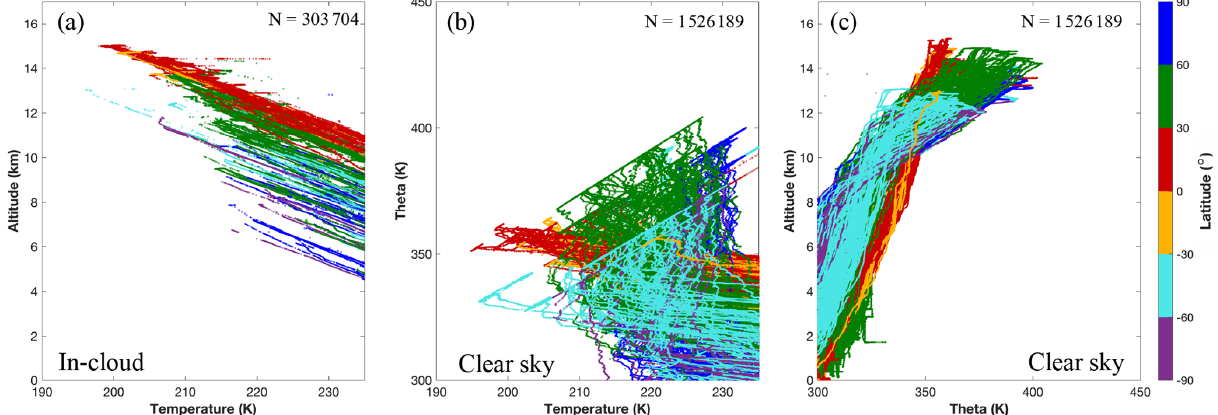
Figure 2. (a) Vertical profiles of temperature, (b) potential temperature vs. temperature and (c) vertical profiles of potential temperature based on in situ observations at temperatures ≤ − 40 ◦ C. Number of samples ( N ) for 1Hz observations is shown in the figure legend. Colors denote six latitudinal